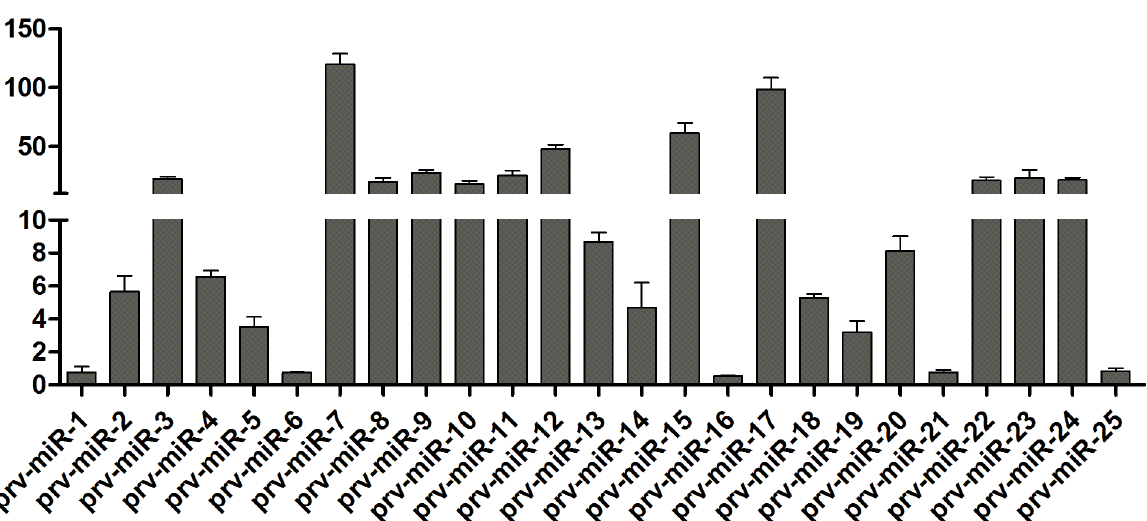
Fig 2. Expression levels detection of virally encoded novel miRNAs using stem-loop qRT-PCR. miRNAs expression levels were normalized to the U6 snRNA. Data are shown as the average ± standard deviation from three independent experiments.